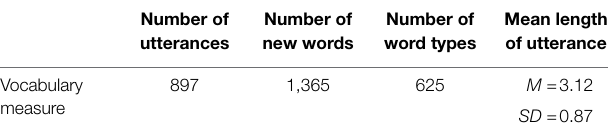
TABLE 2 | Descriptive statistics for Language sample analysis (LSA)